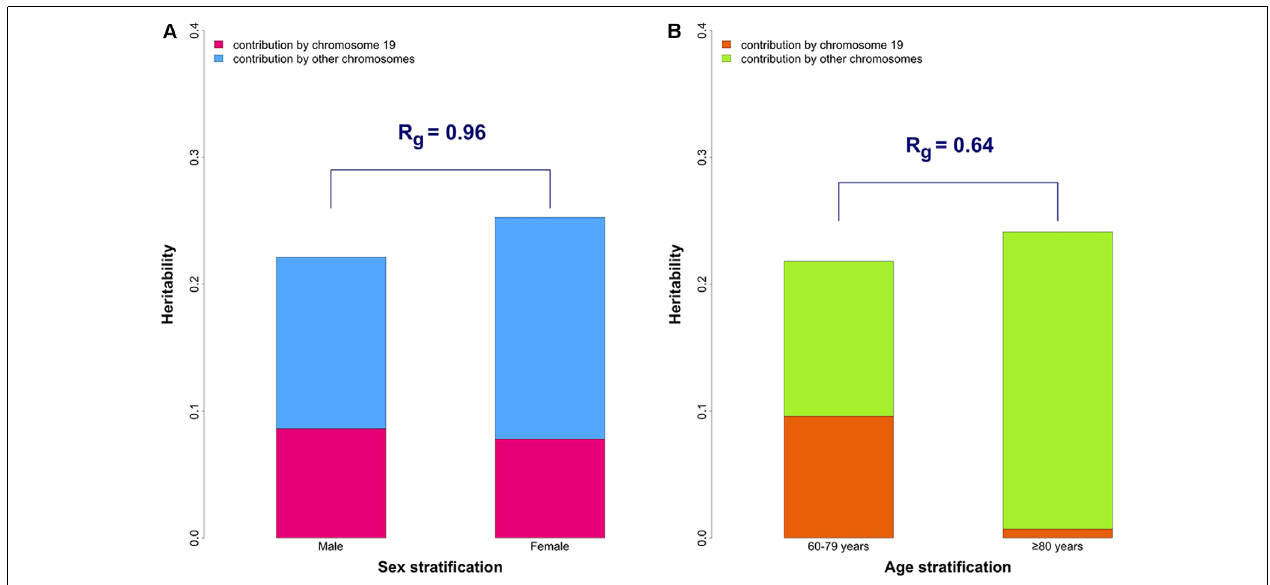
FIGURE 1 | The overall and partitioned heritability estimates in combined phase 1 and 2 samples. (A) Comparison between sexes. The heritability estimates were 19.5% (95% CI: 9.9–29.1%) and 21.5% (95% CI: 15.0–28.1%) in male ( N = 7,216) and female ( N = 10,680) groups, respectively. Heritability estimates of chromosome 19 are 8.6% (95% CI: 5.9–11.4%) in males and 7.8% (95% CI: 5.8–9.8%) in females. The genetic correlation (R g ) between the two sexes was 0.96 ( p -value for H 0 : R g = 1 was 0.42). (B) Comparison between younger (60–79 years old) and older ( ≥ 80 years old) groups (from our previously published data; Lo et al., 2019b). The genetic correlation (R g ) between the two age groups is 0.64 which significantly differs from 1 ( p -value for H 0 : R g = 1 was